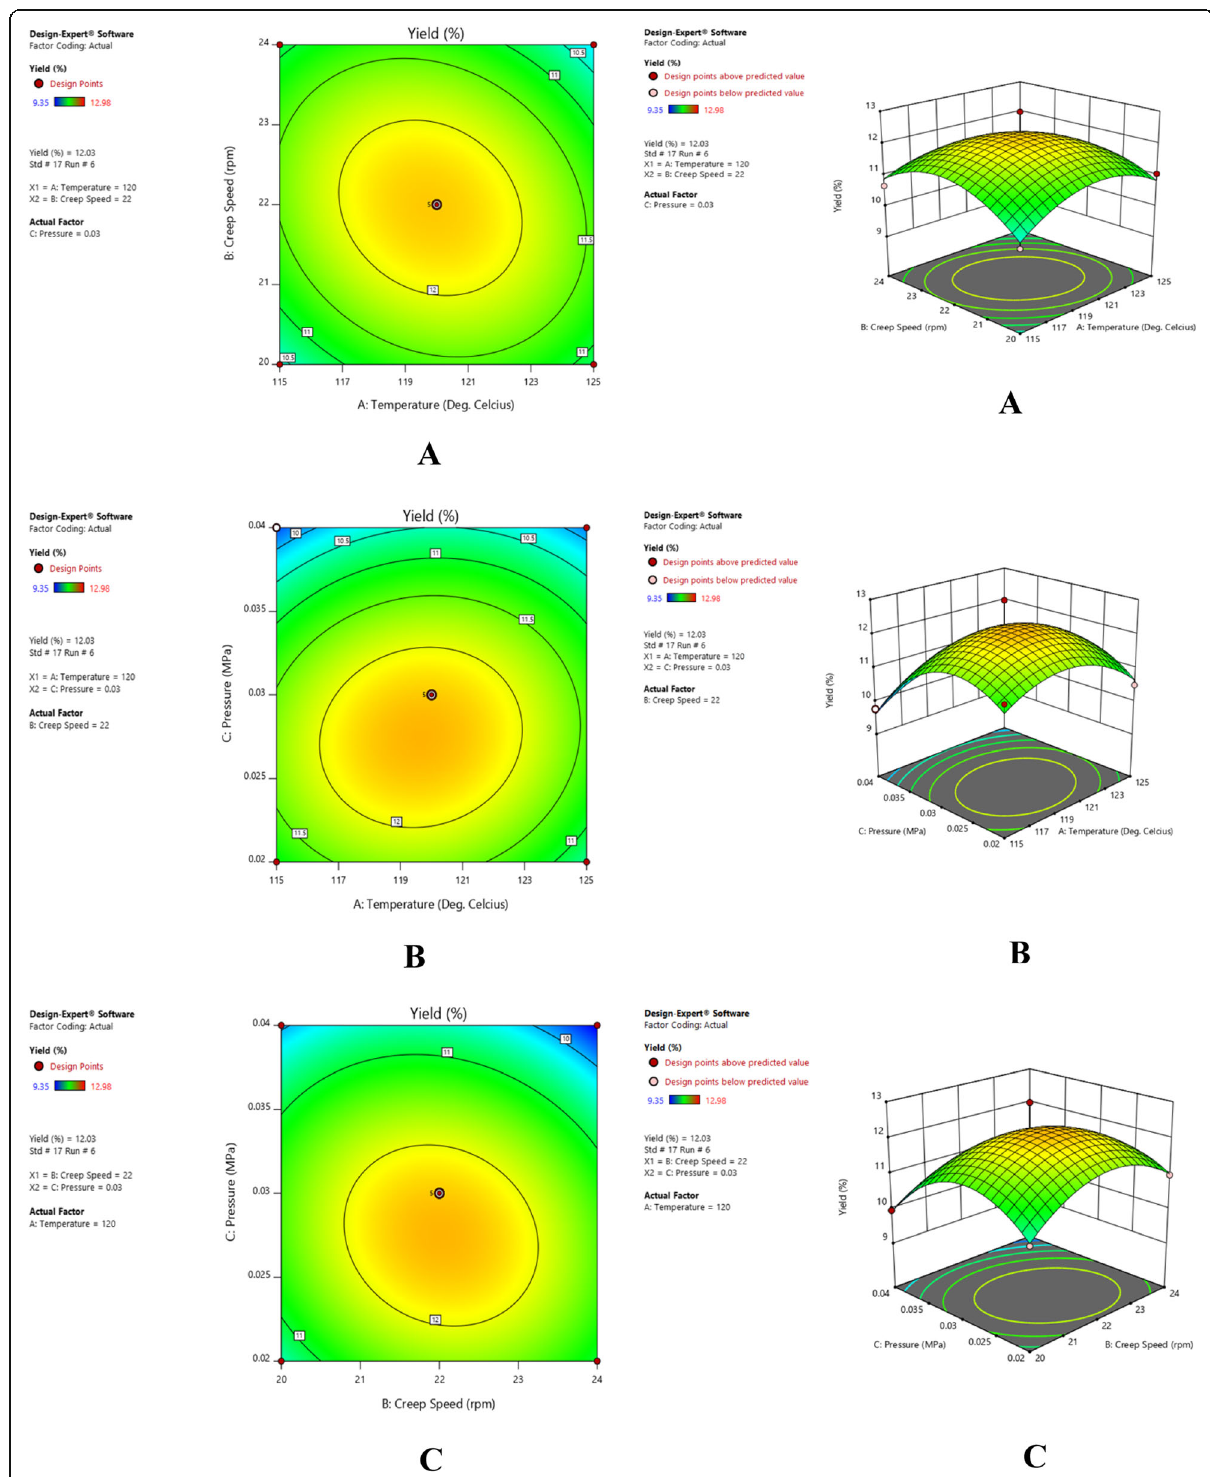
Fig. 2 Result of interactions of independent variables on inulin